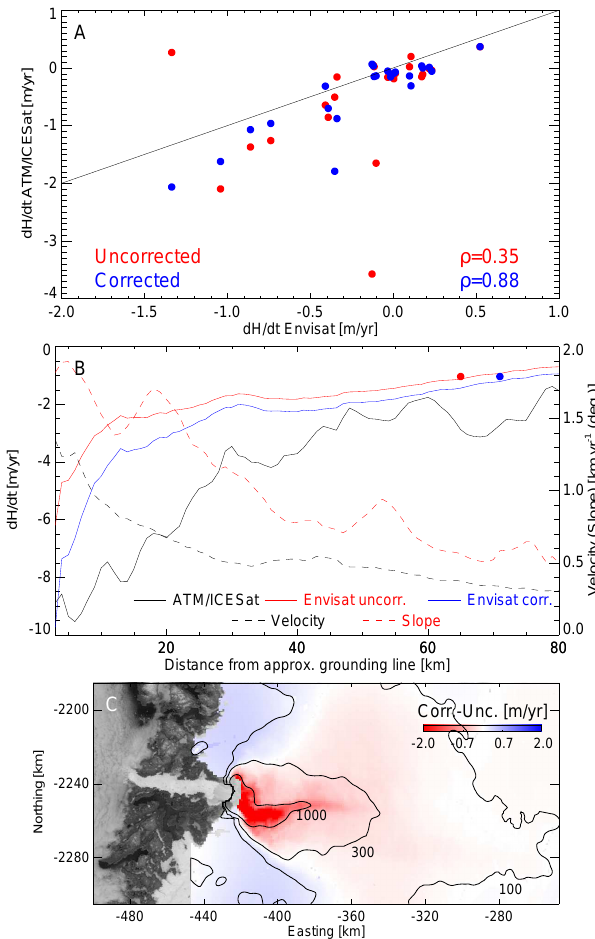
Fig. 3. Comparison of d H /d t from Envisat, before and after slope correction. (A) shows d H /d t from Envisat cross-over clusters ver- sus interpolated d H /d t from ATM/ICESat at the corresponding lo- cations. Red dots show uncorrected, blue dots corrected data. ρ is the Pearson correlation coefficient for both cases. (B) shows inter- polated d H /d t along a transect inland from the grounding zone. All values along the transect are calculated as the north-south average within the 300myr − 1 velocity contour, and the asterisks indicate the (corrected and uncorrected) location of the only Envisat mea- surement in this area (Fig. 1). Also d H /d t from ATM/ICESat and velocity are shown. (C) shows the difference between the interpo- lated d H /d t based on Envisat, before and after correction. Negative values indicate higher values after correction, and velocity is shown as 100, 300, and 1000myr − 1